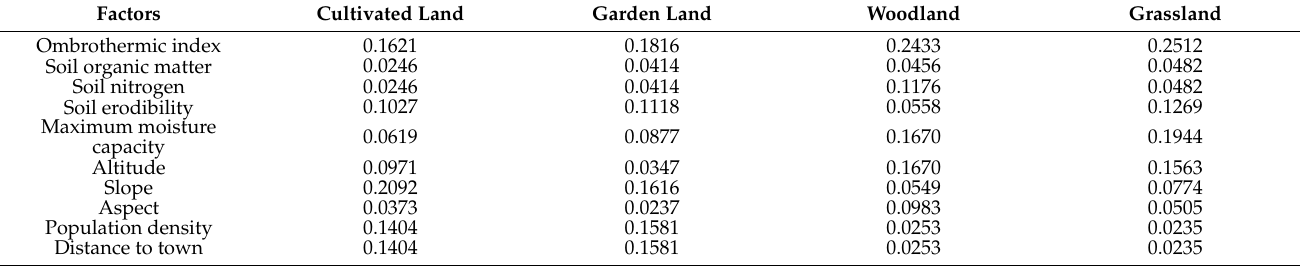
Table 6. Weight of land use suitability evaluation factors based on the analytic hierarchy